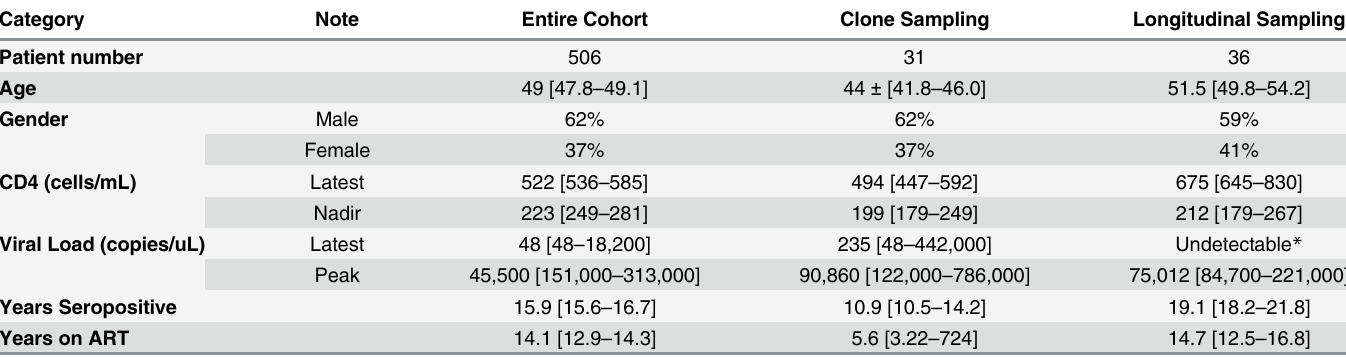
Table 1. Demographics of the entire CARES Cohort as well as the subset of patients that have been included in the CARES longitudinal arm and those that were used for confirmation by subcloning and sequencing. The values indicate the median and 95% confidence intervals. * Due to the longi- tudinal and archival nature of this dataset, the limit of detection with respect to viral load has changed but has ranged from < 100 to <